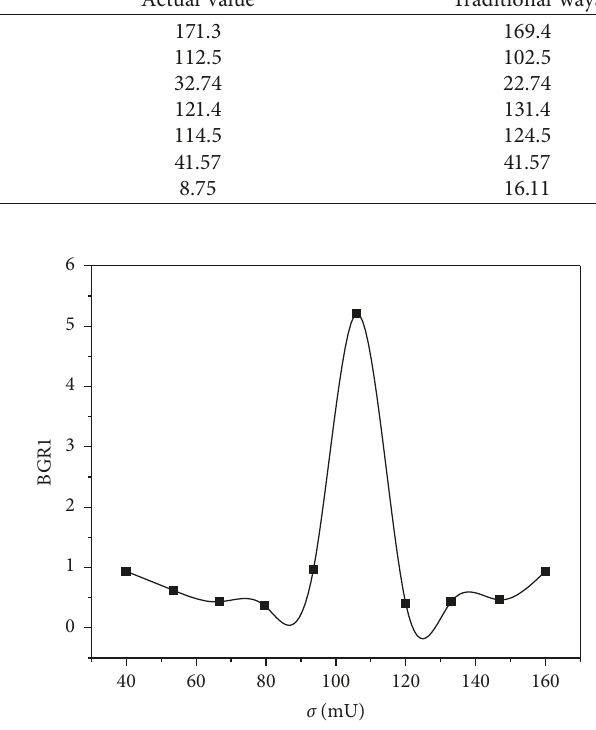
Figure 3: Group B under moderate-intensity aerobic exercise.